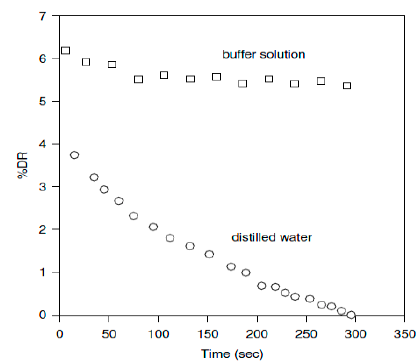
Figure 8. Difference between measured % DR of 1.35 ppm λ -DNA at R e = 7 × 10 5 in a buffer solution and distilled water, reprinted with permission from [79]. Copyright American Physical Society, 2002.